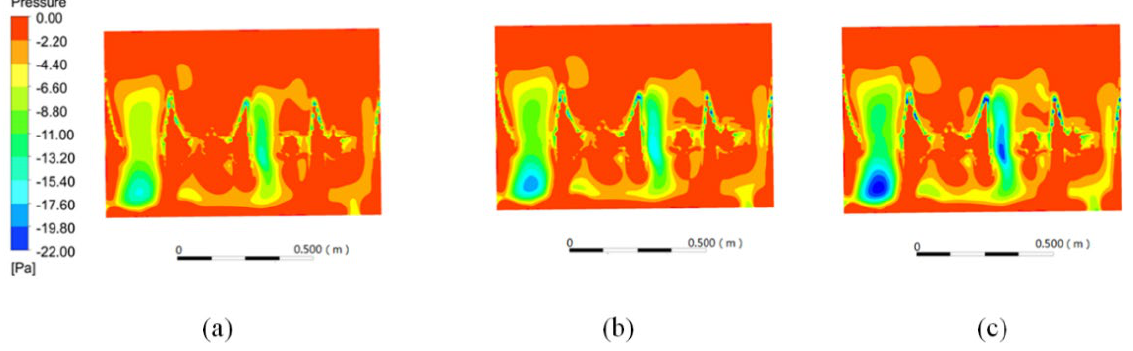
Figure 17. Pressure cloud diagram at the inlet under different WB installation numbers. ( a ) E = 0; ( b ) E = 20; ( c ) E = 40.